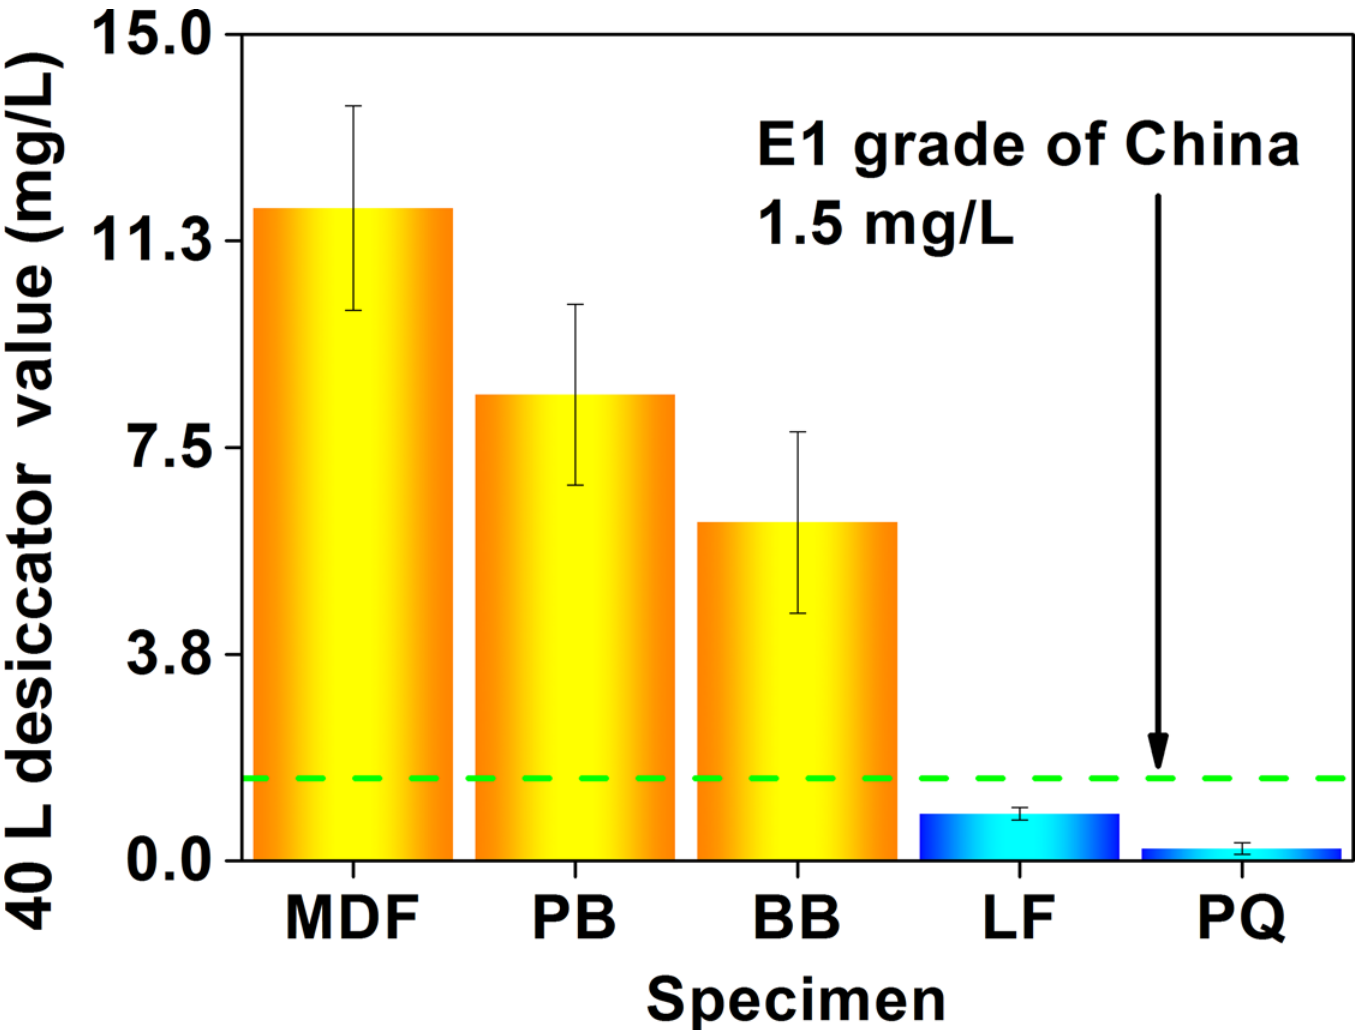
Fig 4. Formaldehyde emission values (40 L desiccator value) of various materials characterized by the 40 L desiccator method of the Chinese national standard GB 18580. MDF, medium density fiberboard; PB, particleboard; BB, blockboard; LF, laminate flooring; PQ,